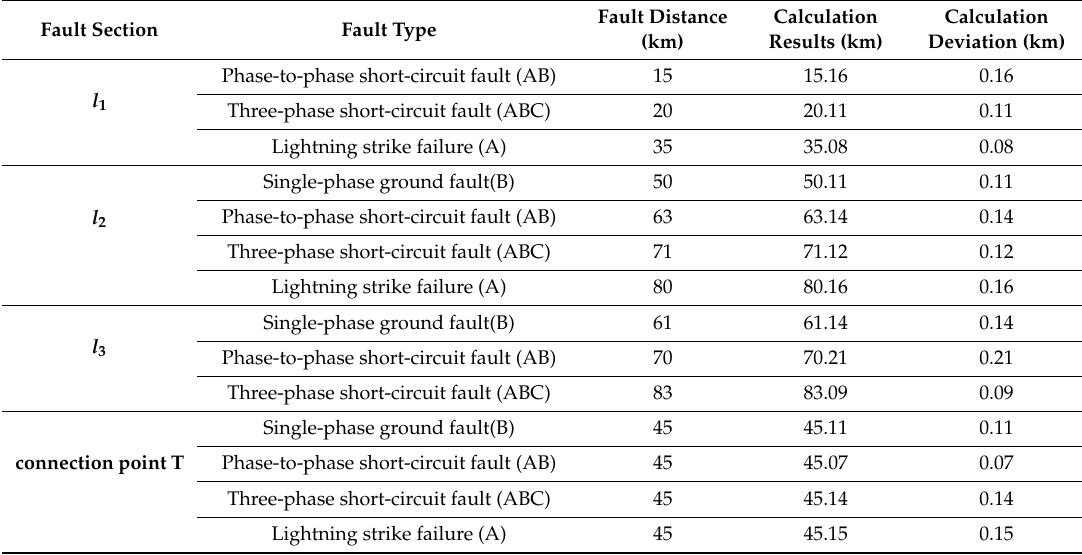
Table 11. Simulation results of various fault situations.